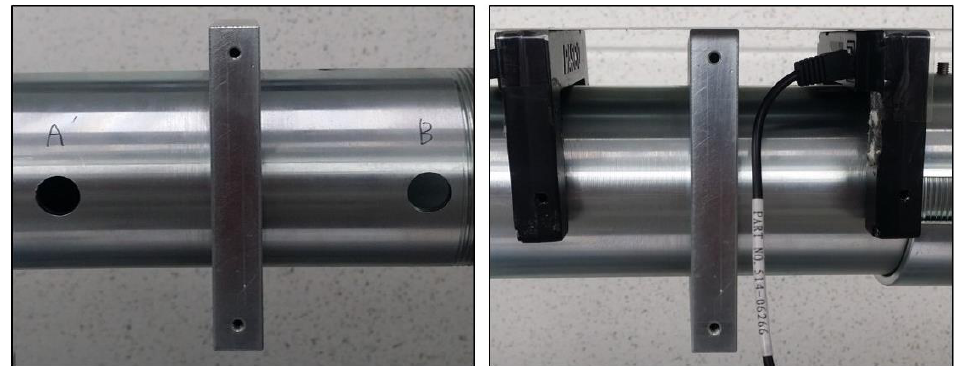
Figure 22. Photogate installed on the SHPB apparatus.